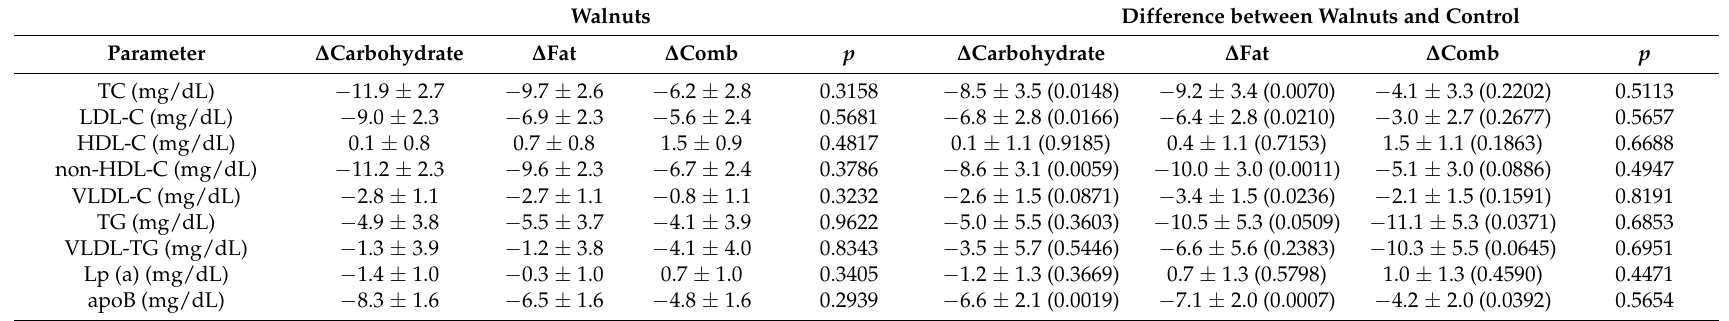
Table 3. Effect of walnut consumption on fasting lipids, apoB and Lp (a) when walnuts replace carbohydrates, fat, or